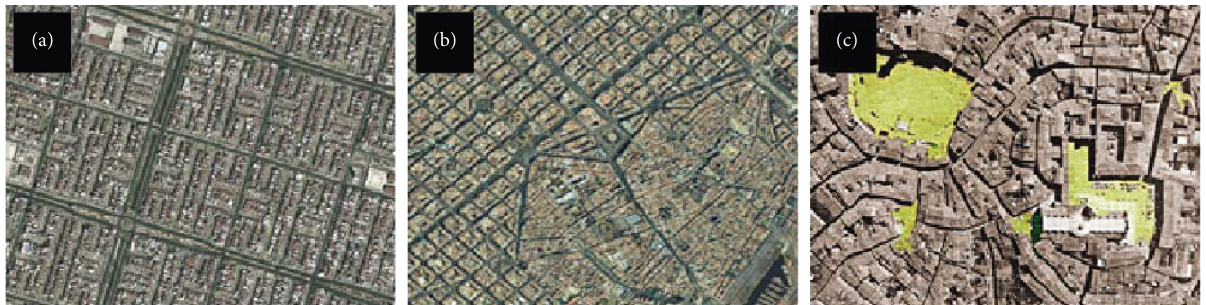
Figure 3: Difference between urban network patterns, from regular to random. (a) Up Down cities. (b) Mixed Pattern cities. (c) Bottom Up cities (source: maps of Mexico, Barcelona, and